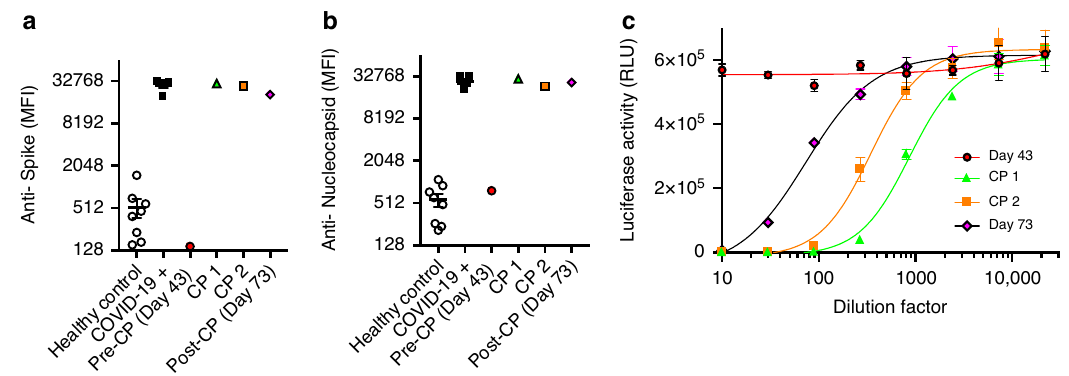
Fig. 2 Kinetic assessment of the antigen-speci fi c humoral responses. Serological reactivity to SARS-CoV-2 spike a and nucleocapsid b antigens of patient sera obtained at indicated time points, the fi rst (CP 1) and second (CP 2) infusions of convalescent plasma (CP), sera from healthy controls ( n = 8 biologically independent subjects) and patients ( n = 5 biologically independent subjects) with PCR-con fi rmed COVID-19 (MFI, mean fl uorescence intensity; Mean and SEM). c Neutralisation activity against SARS-CoV-2 spike-pseudotyped lentiviral particles of patient sera obtained at indicated time points, compared with the fi rst (CP 1) and second (CP 2) infusions of convalescent plasma (CP). ( n = 1 independent biological samples, n = 3 technical replicates from each sample; mean and SD). Data from one independent